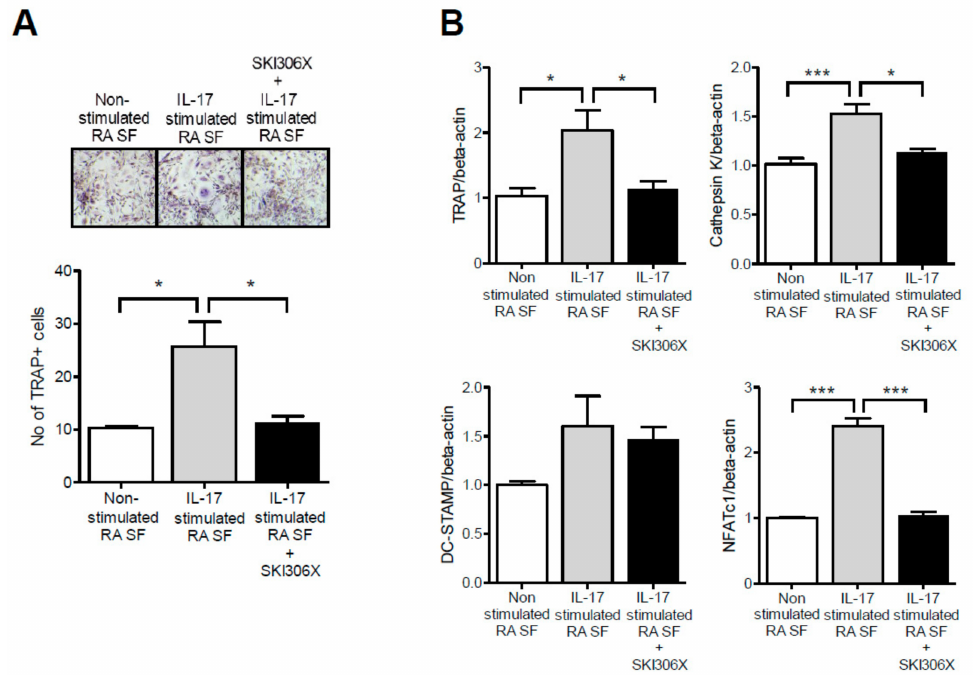
Figure 5. The regulatory e ff ect of SKI306X on osteoclast di ff erentiation in co-cultures of PB monocytes and IL-17-stimulated synovial fibroblasts (SF) in RA. ( A ) After PB monocytes were co-cultured with IL-17 stimulated RA synovial fibroblasts in the presence of monocyte colony stimulating factor and SKI306X for 21 days, the TRAP-positive multinucleated cells were enumerated. The figures represent one of three independent experiments and the bars represent mean ± SD values. ( B ) The expression of osteoclast markers including TRAP, cathepsin K, DC-STAMP, and nuclear factor of activated T-cells, cytoplasmic 1 (NF-ATc1) was quantified using real-time PCR, normalized to beta-actin and reported in relative expression units. * p < 0.05 and *** p <